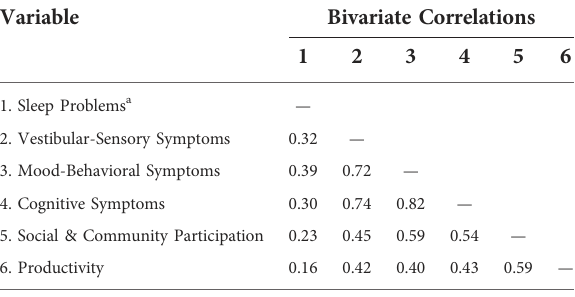
TABLE 3 Bivariate correlations for key study variables ( n